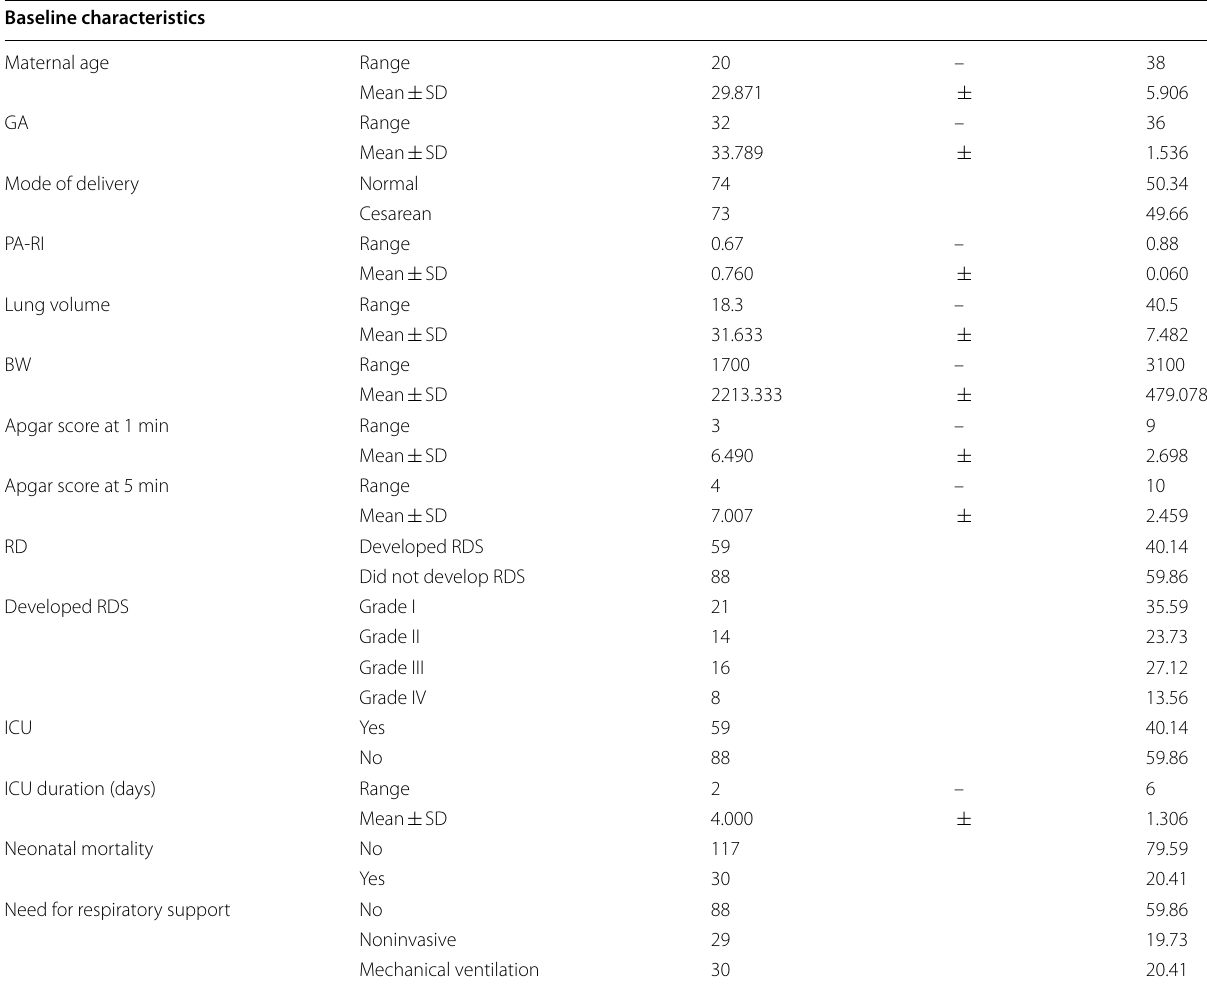
Table 1 Demographic data of the included women regarding (maternal age, gestational age, and mode of delivery, PA‑RI, lung volume and fetal outcome) Baseline